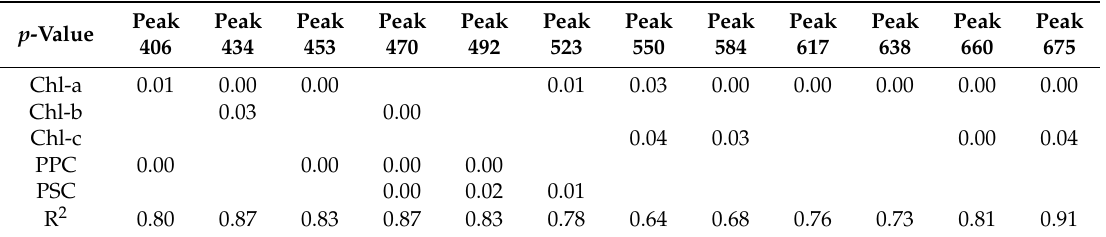
Figure 2. a Gau ( λ ) estimated pigment concentrations versus the measured concentrations from HPLC using the a ph ( λ ) and HPLC from SeaBASS: A : chlorophyll a (Chl-a), B : chlorophyll b (Chl-b), C : chlorophyll c (Chl-c), D : photoprotective carotenoids (PPC), and E : photosynthetic carotenoids (PSC). Table 3. The p -value and R 2 from the t-statistics, with a Gau ( λ ) at 12 different wavelengths: 406, 434, 453, 470, 492, 523, 550, 584, 617, 638, 660, and 675 nm, and Chl-a: chlorophyll a , Chl-b: chlorophyll b , Chl-c: chlorophyll c , PPC: photo-protective carotenoids, PSC: photosynthetic